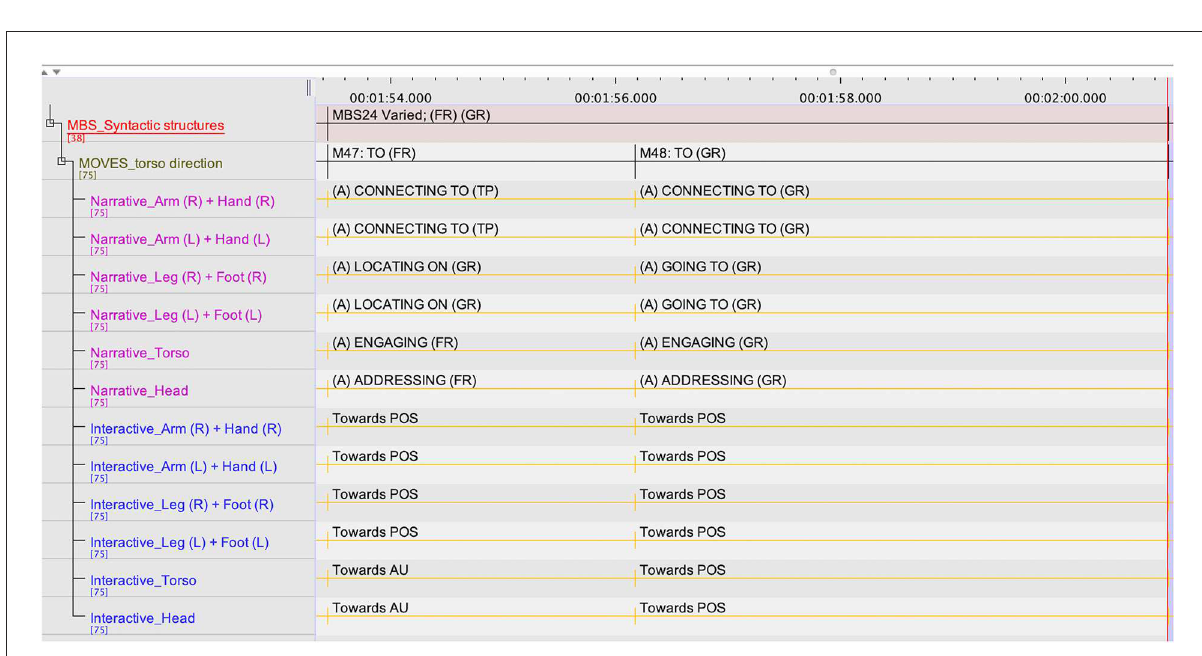
FIGURE4 The tier at MBS level (MBS 24) and the tiers at move level ( moves 47 and 48) coding narrative and interactive projections.